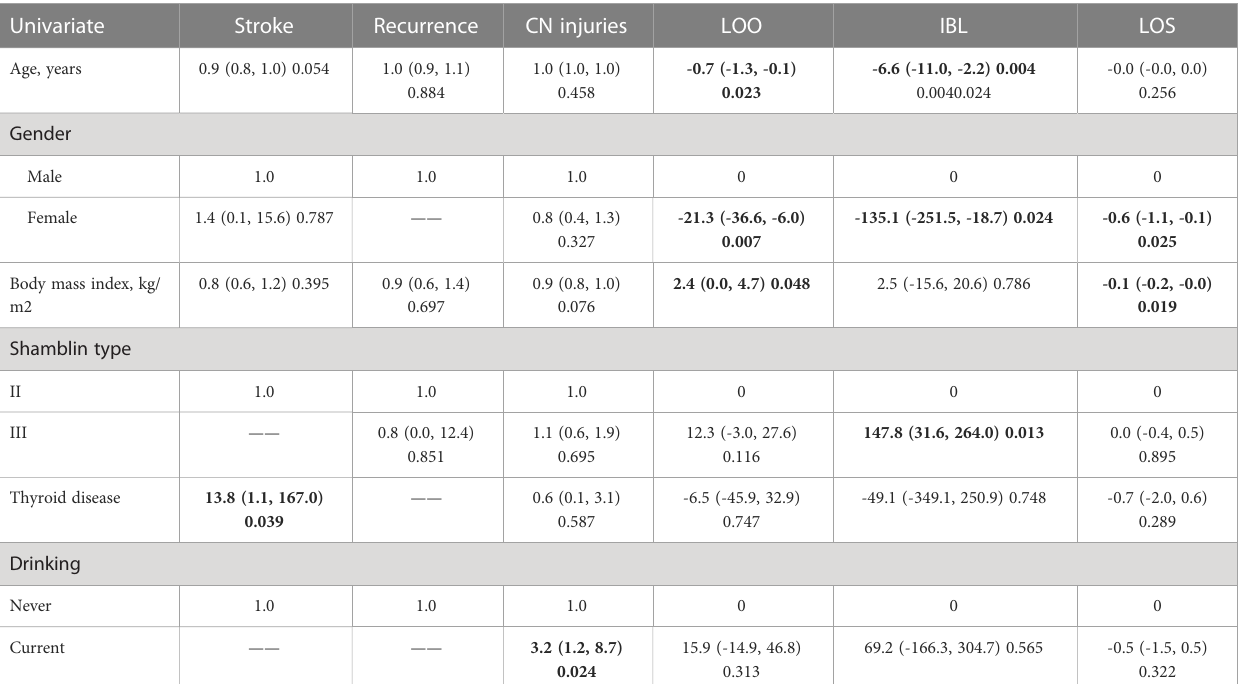
TABLE 2 Univariate regression analysis for primary and secondary outcomes.